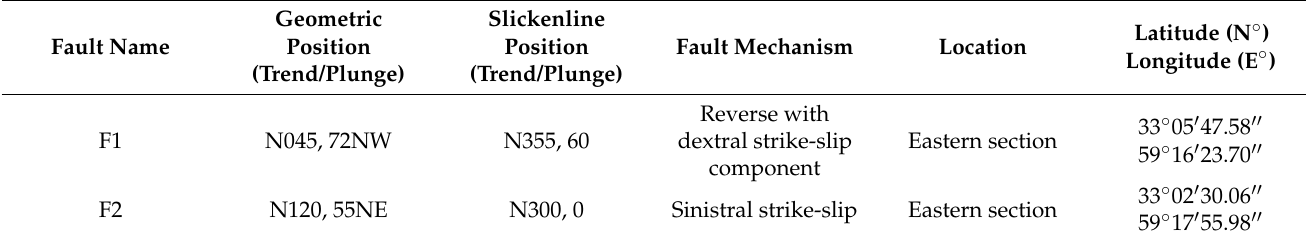
Table 1. Geometric–kinematic location of the detected faults in the research area; N.B.F = North Birjand